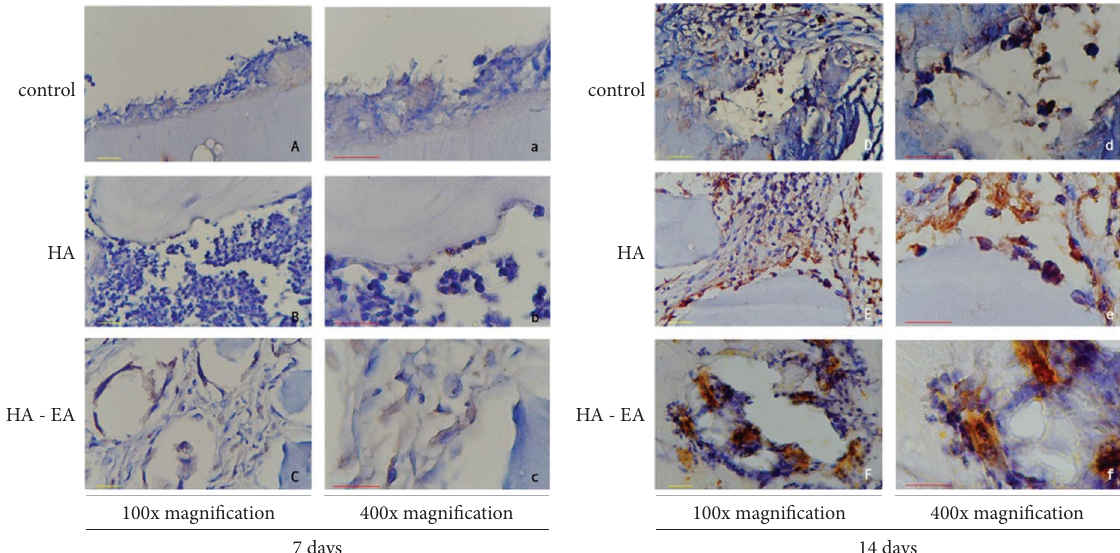
Figure 4: BMP-4 expression in bone tissue 7 days after application (a, b, and c) and 14 days after application (d, e, and f). Te BMP-4 expression was expressed in osteoblast as brown colour in fgures.